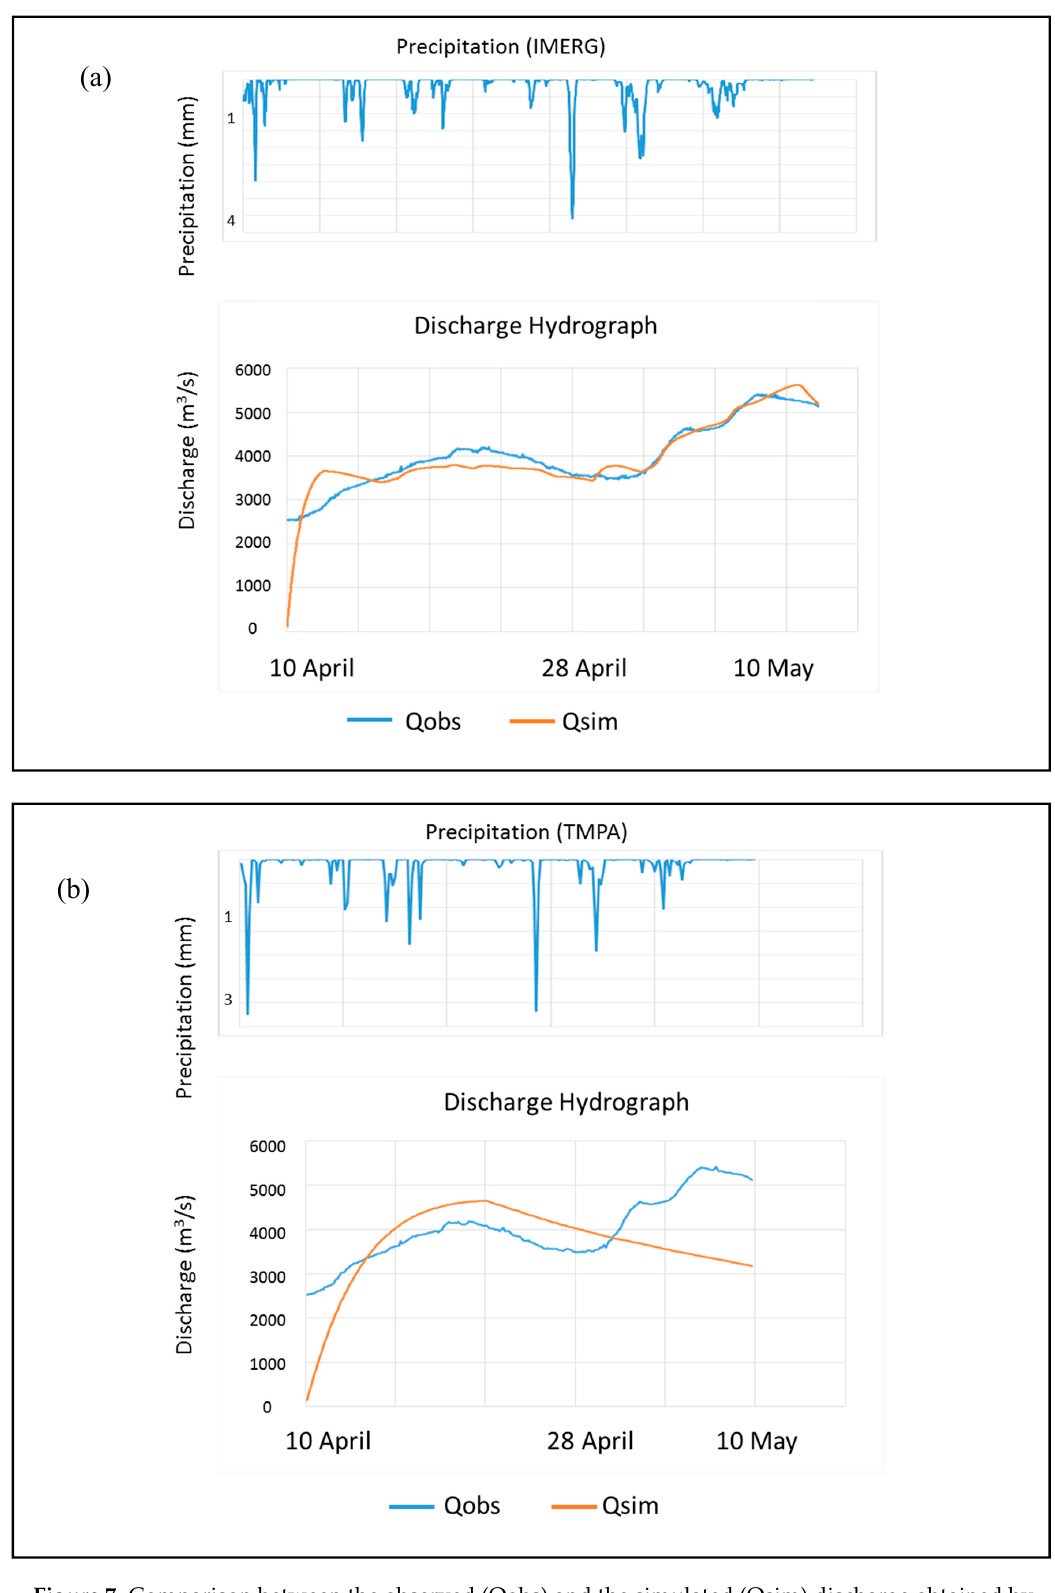
Figure 7. Comparison between the observed (Qobs) and the simulated (Qsim) discharge obtained by the MILc model based on satellite precipitation products after calibration for ( a ) IMERG and ( b ) TMPA precipitation data.